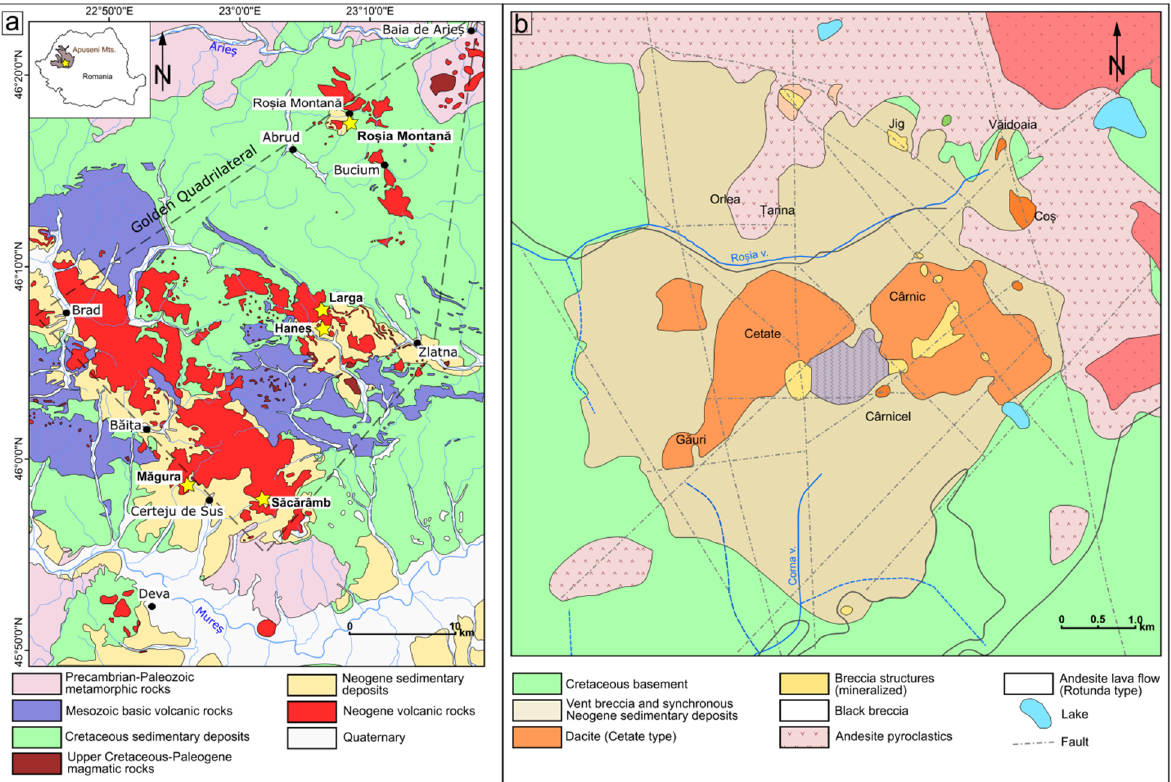
Figure 1. General geology data: ( a ) simplified geology of the South Apuseni Mountains (SAM) and the location of the ore deposits with published data on sphalerite (modified after [21,22]; and ( b ) geological map of the Ro ș ia Montan ă ore deposit (modified after [23]).